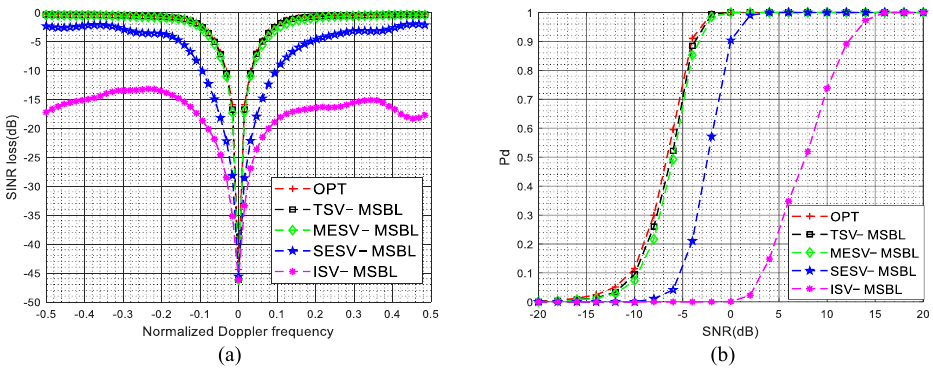
Figure 5. SINR loss curves and PD versus SNR curves in the presence of gain and phase errors. ( a ) SINR loss versus the normalized Doppler frequency in the presence of gain and phase errors; ( b ) PD versus SNR ( f st = 0.1) in the presence of gain and phase errors.